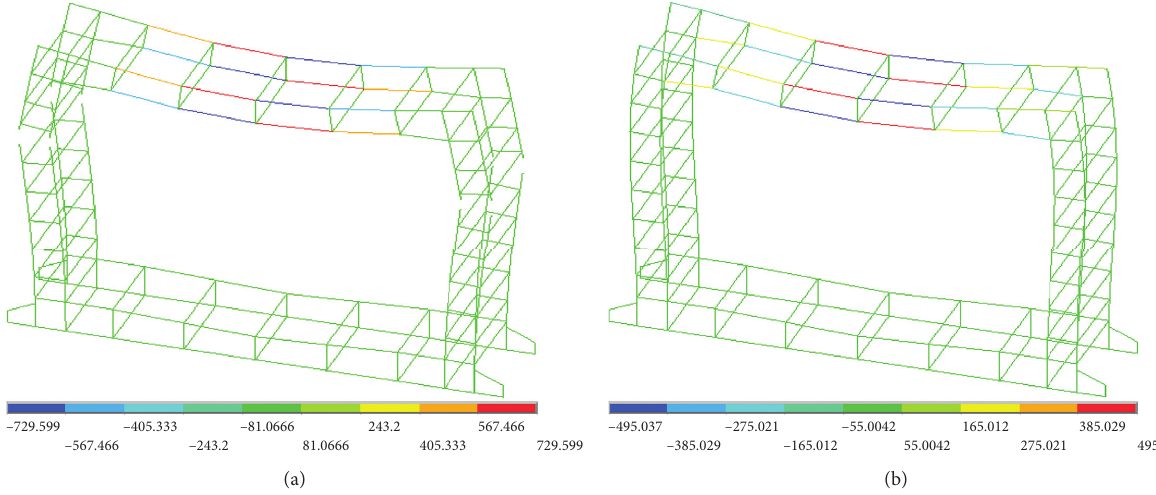
Figure 12: Axial force diagrams of BC reinforcement in the X -direction. (a) Round hinged type BC. (b) Integral type BC.